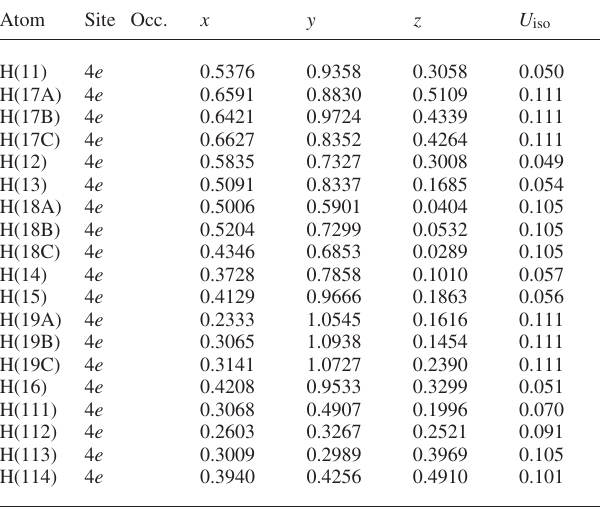
Table 2. Atomic coordinates and displacement parameters (in Å 2 )